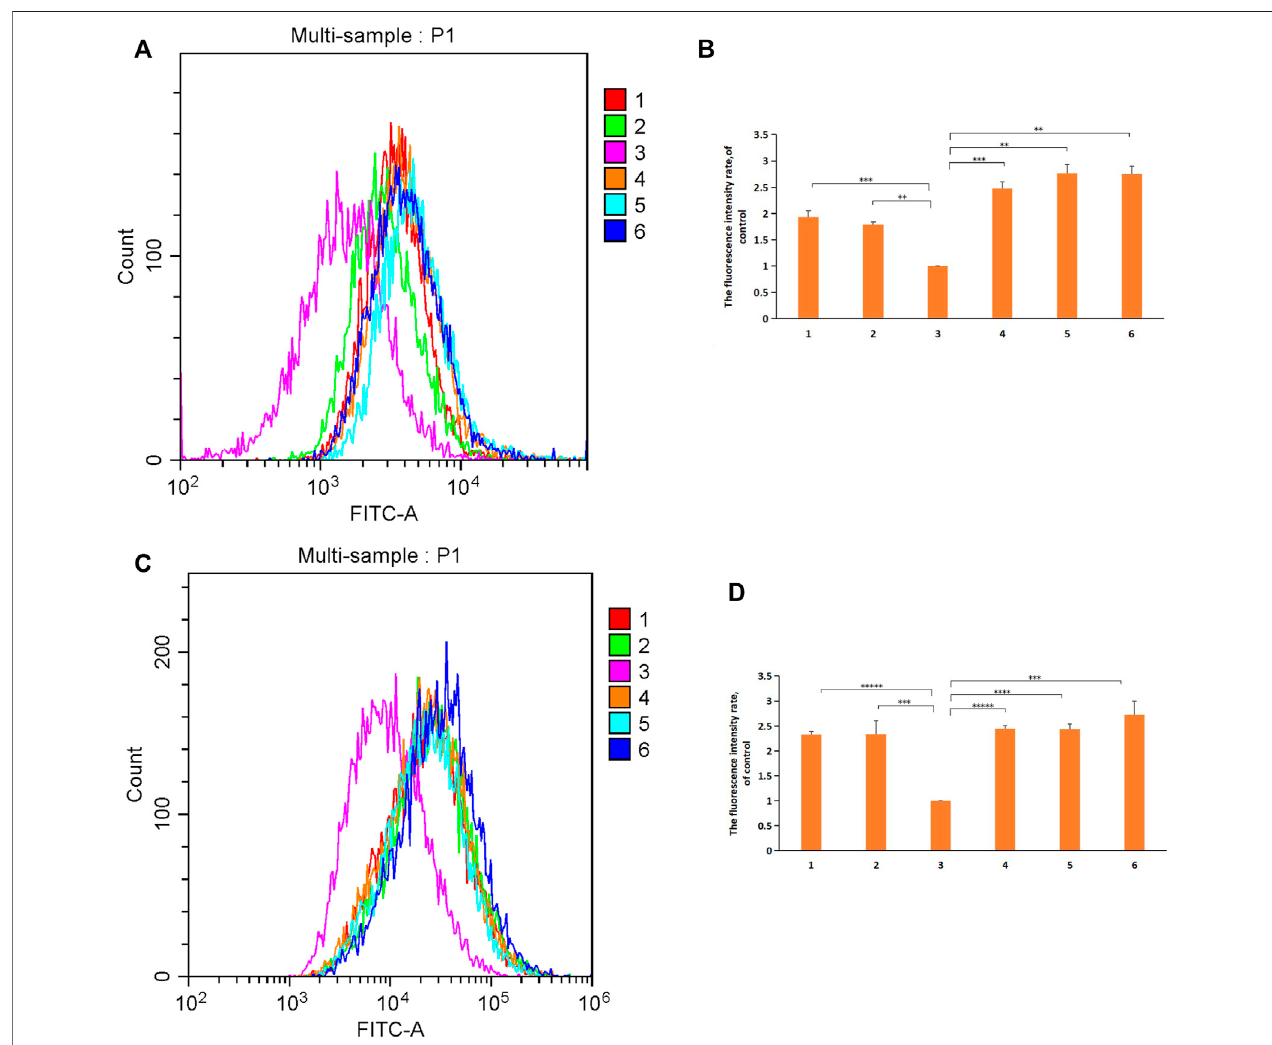
FIGURE9| EffectofmicellesandfreeDOXonROSlevelsinH9c2cellsandBEL-7402cells:DSPE-PEG-C60:DOX=10:1(W/W)(1),DSPE-PEG-C60:DOX=15:1 (W/W)(2), control(3),DSPE-PEG-NH 2 : DOX=10:1(W/W) (4),DSPE-PEG-NH 2 :DOX=15:1 (W/W) (5),and freeDOX(6).Cellswere treatedwithmicellesorfreeDOXfor 24 h, followed by DCFDA staining and fl ow cytometry detection. (A) Representative fl uorescence intensity plots of DCF in H9c2 cells. (B) Fluorescence intensity rate of the calculated H9c2 cells. (C) Representative fl uorescence intensity plots of DCF in BEL-7402 cells. (D) Fluorescence intensity rate of the calculated